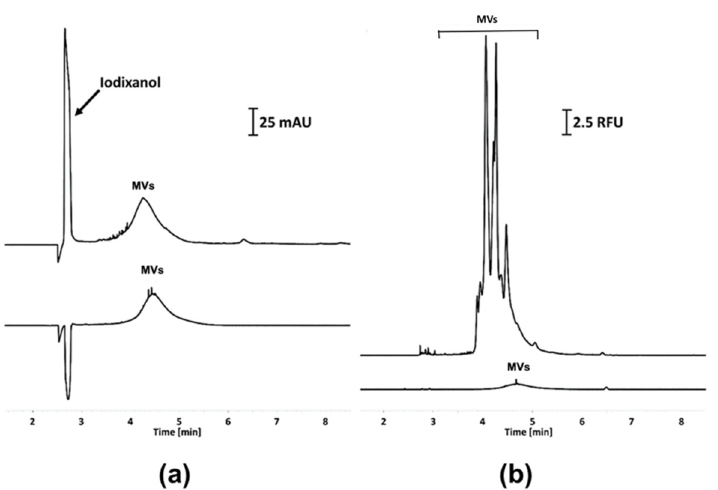
Figure 4. The CE analysis of the MVs isolated from culturing media of (lower traces) the wild-type P. zantedeschiae 9M and (upper traces) the GFP-tagged strain. The analyses were performed using ( a ) UV and ( b ) LIF detection. The abbreviations used are: RFU—relative fluorescence unit; AU—absorbance unit.